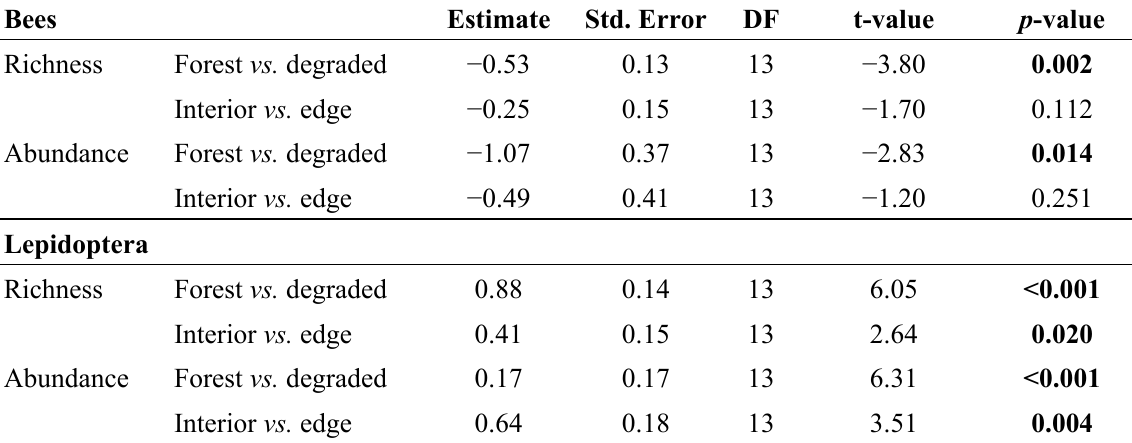
Table 1. Differences in species richness and abundance of two pollinator guilds (bees and butterflies/moths) between three habitat types at eight study sites in the Bolivian Andes.